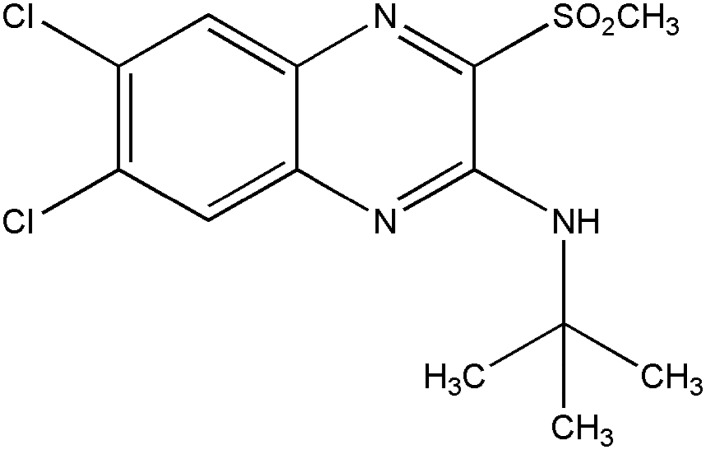
Structure of DMB, molecular formula C13H15Cl2N3O2S.